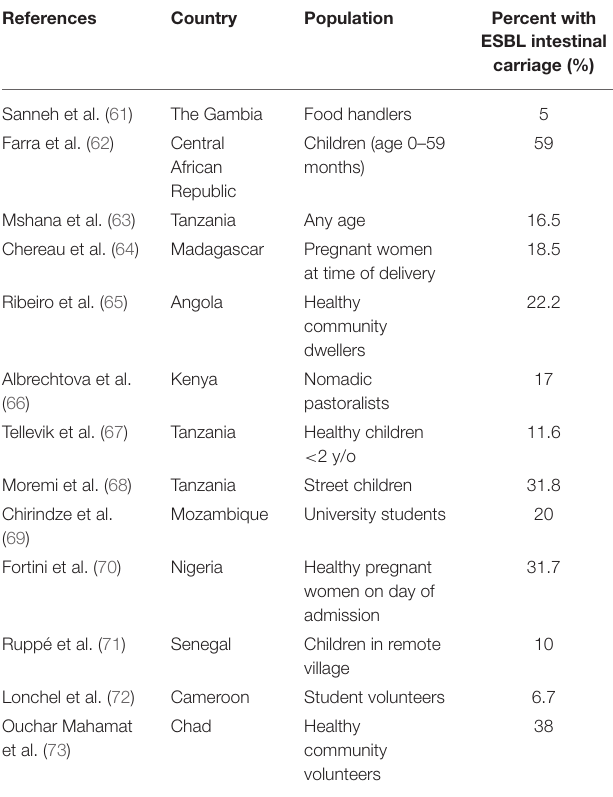
TABLE 1 | Studies evaluating rates of ESBL-E carriage in